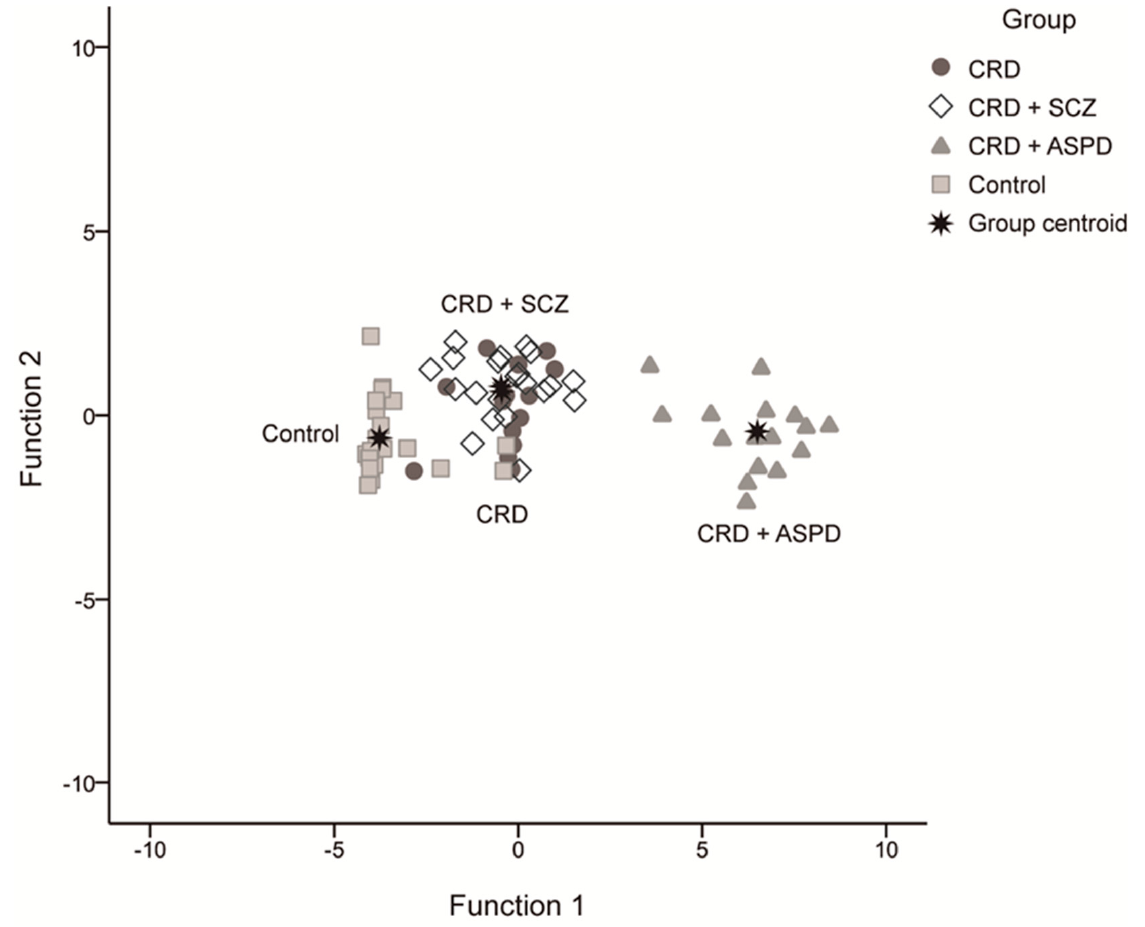
Figure 3. Scatter diagram for the discriminating functions. CRD: cocaine-related disorder; SCZ: schizophrenia; APD: antisocial personality disorder.